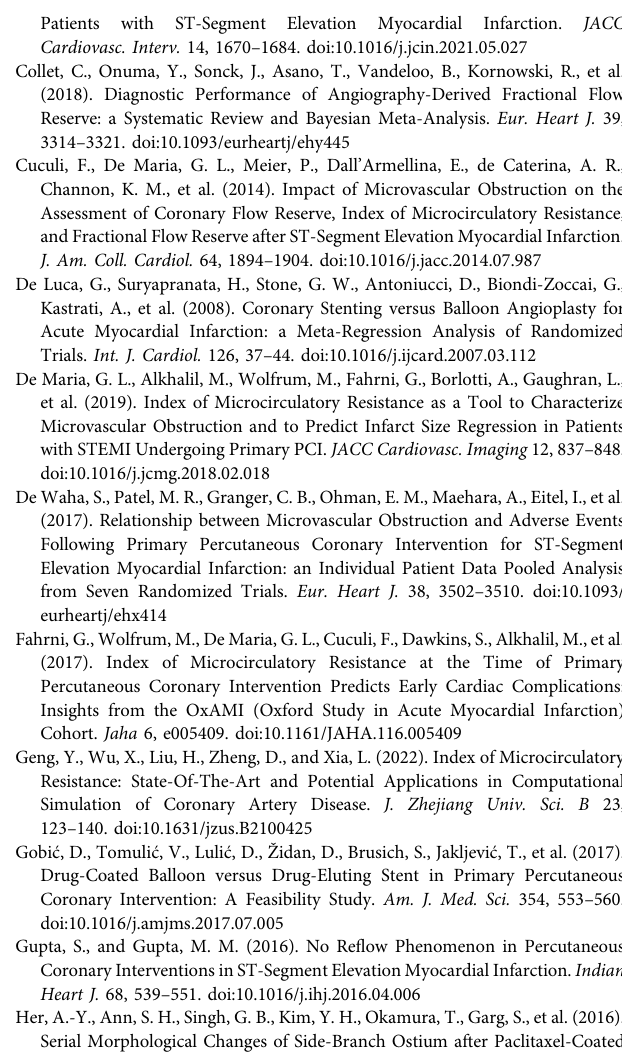
Supplementary Table S5 | Baseline characteristics of the study population grouped by